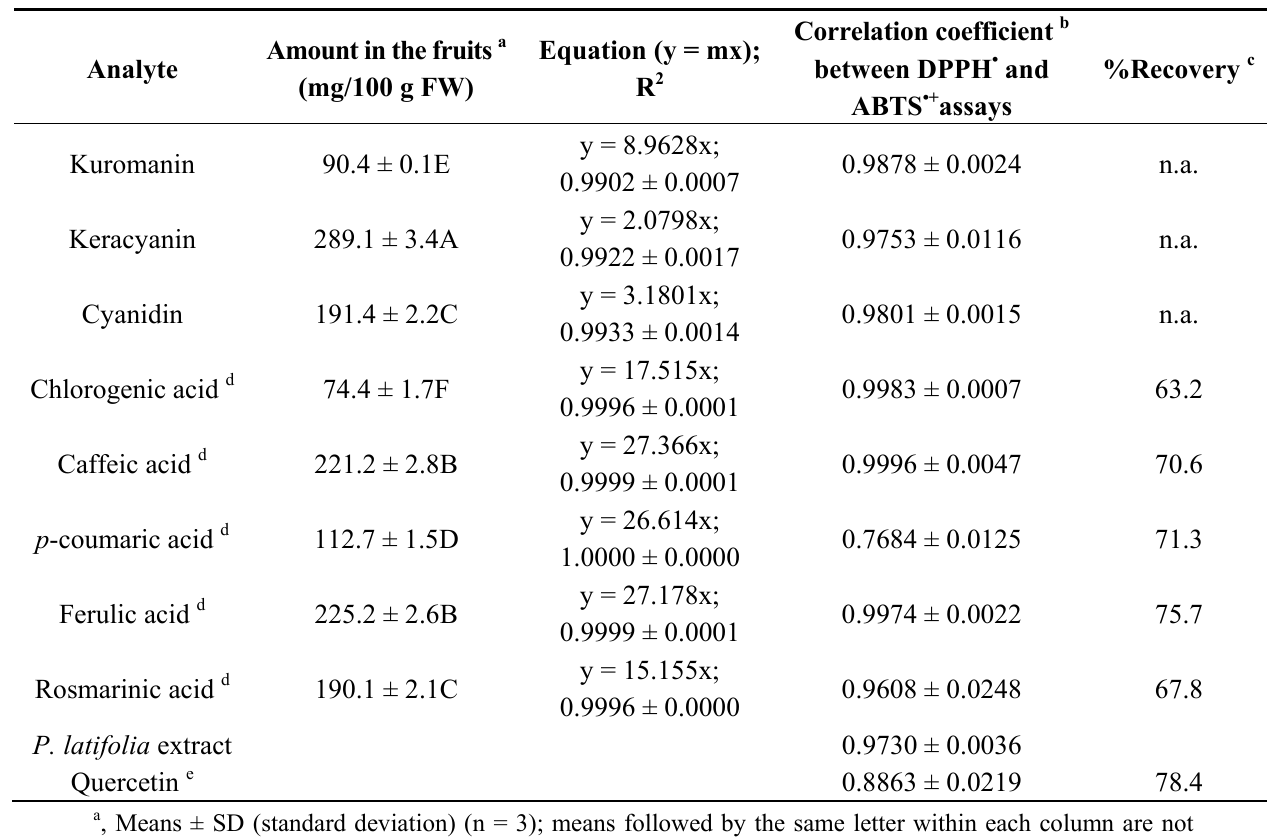
Table 1. Amounts and squared regression coefficients (R 2 ) obtained from chromatographic analysis, correlation coefficients between DPPH • and ABTS • + assay results and recovery percentages of individual phenolic compounds obtained from an acid-hydrolyzed standard